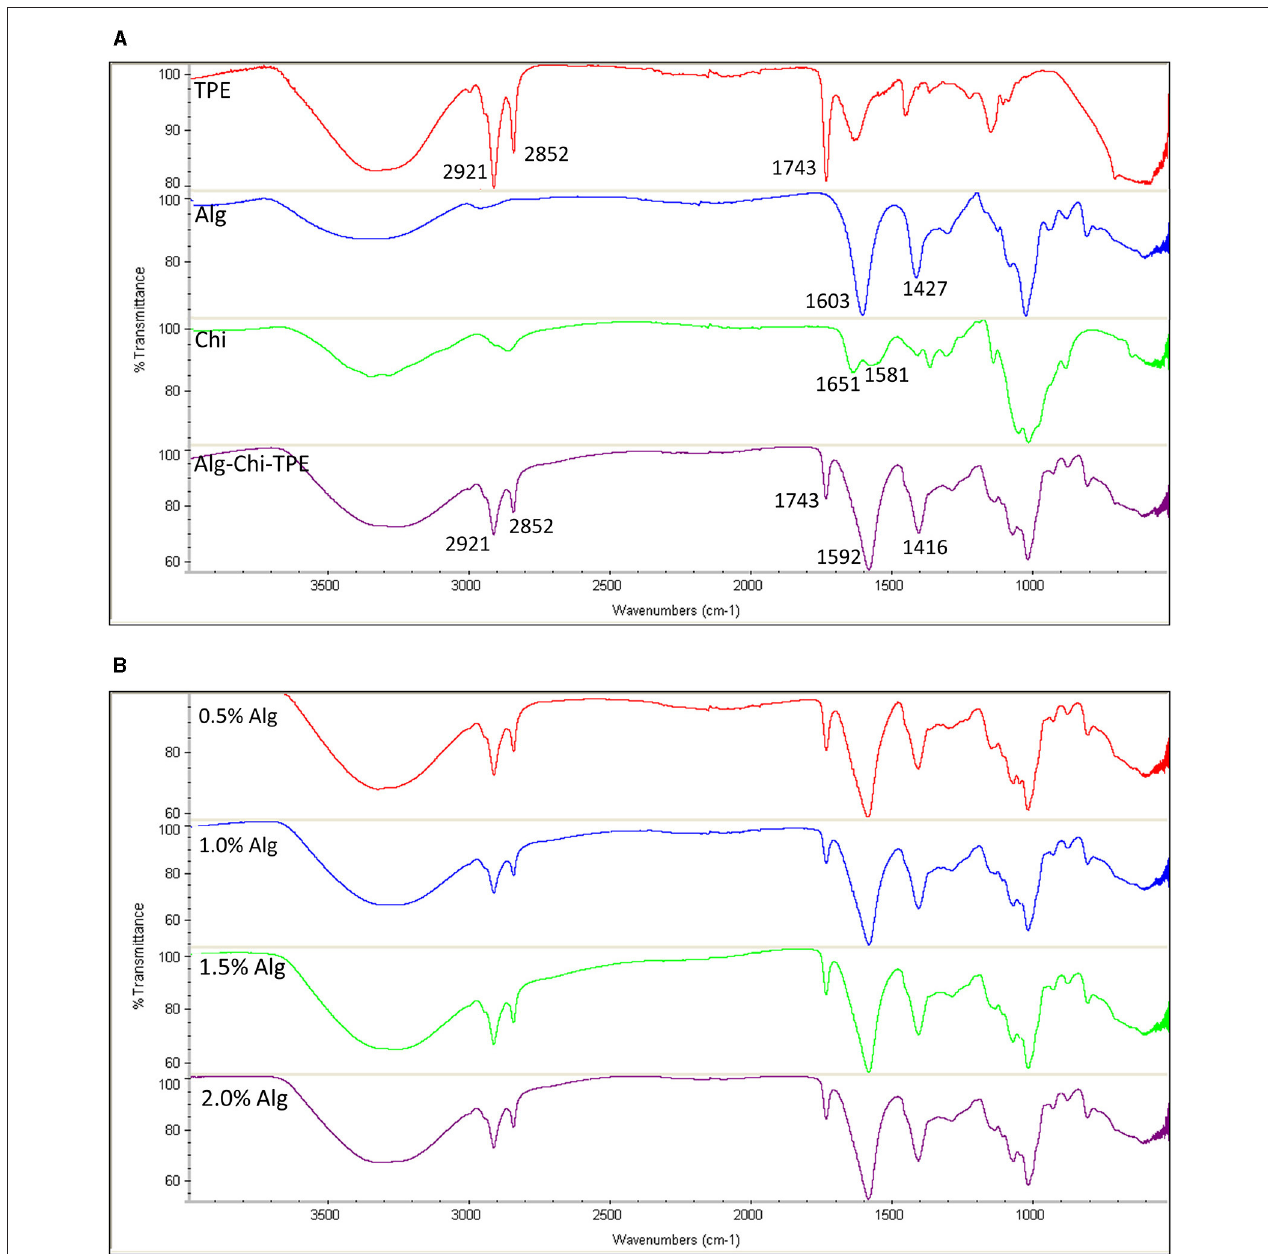
FIGURE 3 | FTIR spectra of (A) TPE, Alg, Chi, and Alg-Chi-TPE beads (B) different alginate concentrations (0.5–2.0% w/v).